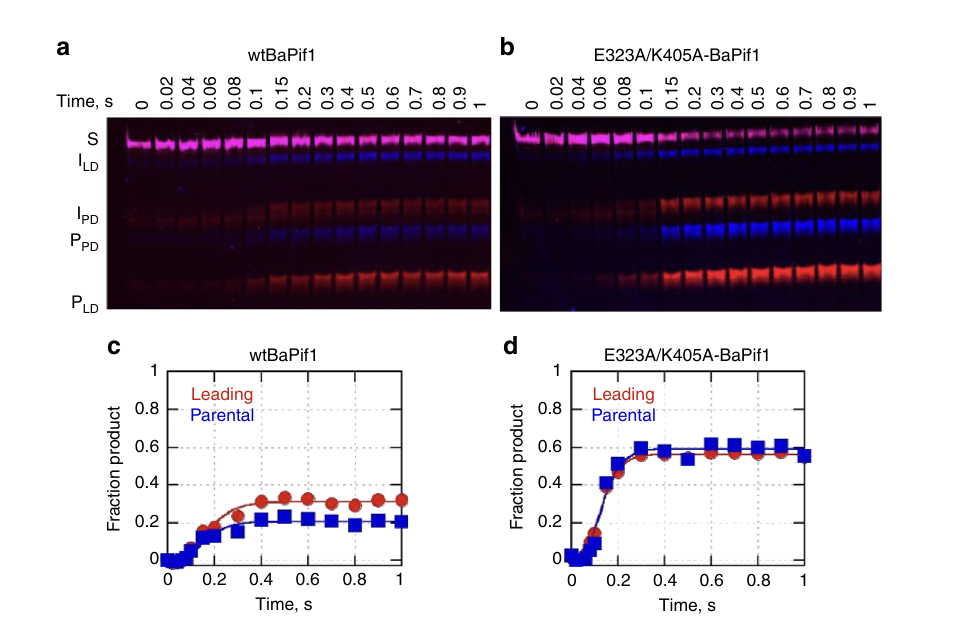
Fig. 6 Rapid chemical quench fl ow reactions to measure rate of unwinding the parental and the leading duplexes. a Single turnover unwinding assay with wtBaPif1 and E323A/K405A ( b ) to determine rates of unwinding. c Quanti fi cation of the unwinding reaction with wild type BaPif1. The leading duplex was unwound (circles) at 21 ± 2 s − 1 and the parental duplex (squares) at 21 ± 3 s − 1 . d Quanti fi cation of the unwinding reaction with E323A/K405A mutant of BaPif1: The mutant unwound the leading duplex (circles) at 33 ± 1 s − 1 and the parental duplex (squares) at 31 ± 3 s − 1 . Errors are the standard error of the fi t. n = 2 independent experiments. Source gels and quanti fi cation data are provided as a Source Data fi showing two interacting SF1 helicases that are bound at forked dsDNA, with one monomer bound to the 3 ’ -arm and the other to the 5 ’ -arm, yet both are active on their respective strands.